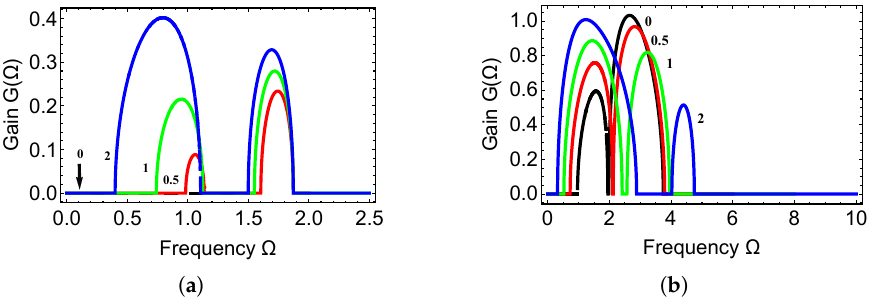
Figure 7. ( a ) The MI gain spectra in the normal-GVD regime ( σ 1 = − 1); ( a ) the results for different values of the ratio of the nonlinearity coefficient in the two cores ( Γ ), indicated near the curves. Other parameters are P = 1, η = 0.5, α = 1, κ = 0.7 and ρ = 0.1. ( b ) The results for different values of the group-velocity mismatch ( ρ ), indicated near the curves. Other parameters are P = 1, η = 0.5, α = 0.1, Γ = 2, κ =